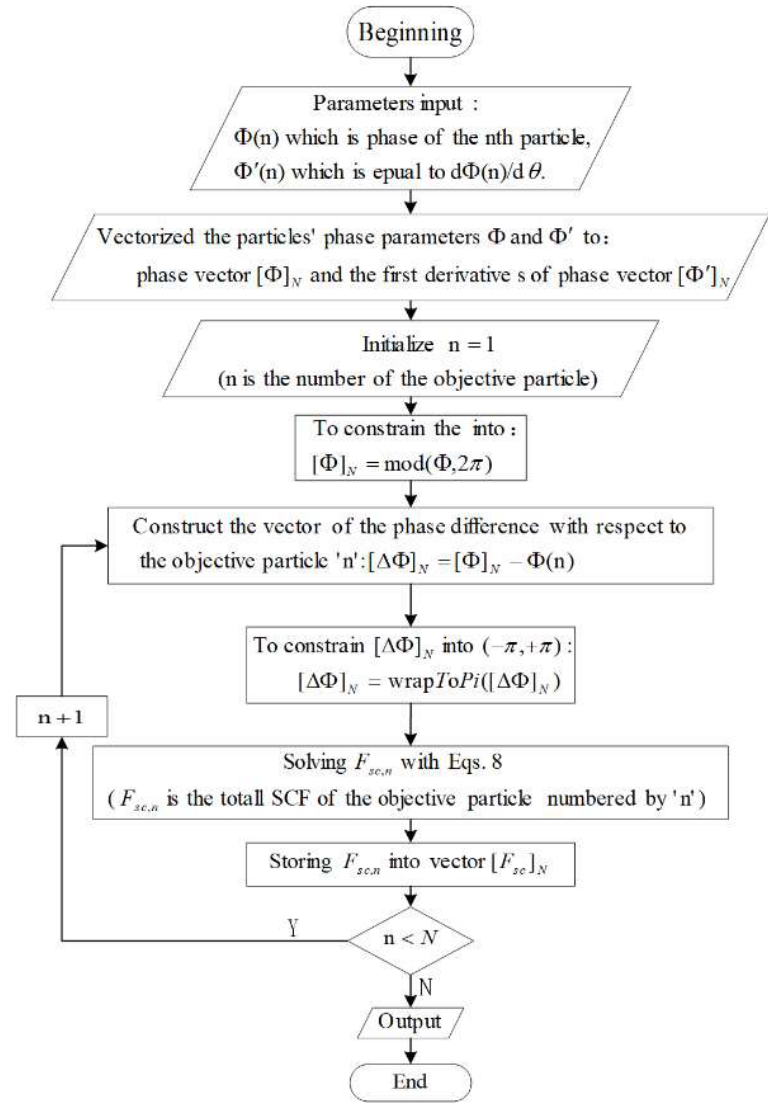
Figure 6. The schematic diagram of the vectorized algorithm.